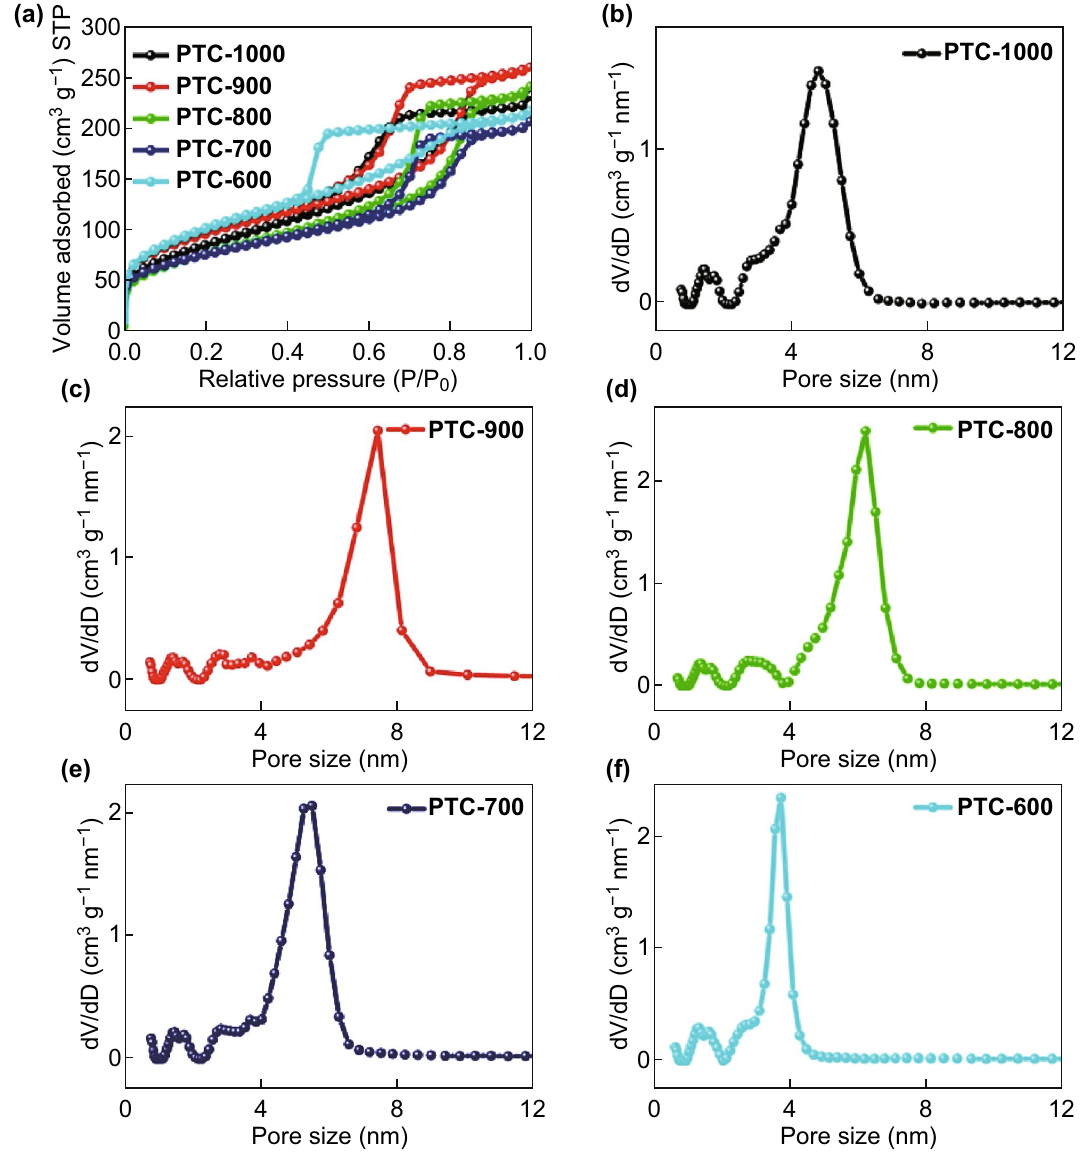
Fig. 4 a Nitrogen adsorption–desorption isotherms and b–f the pore size distribution of PTC annealed at different temperatures in the range 600–1000